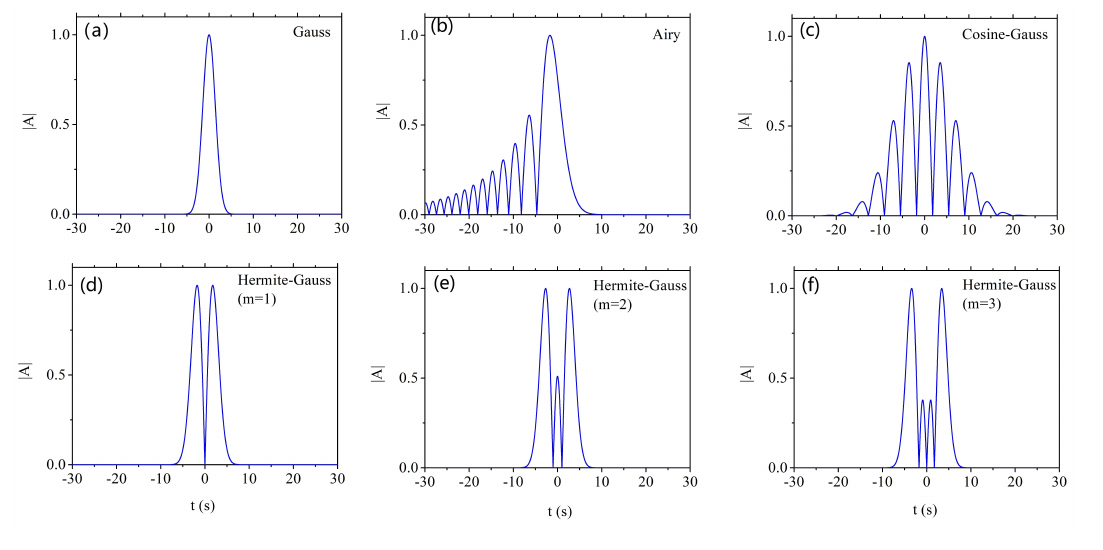
Figure 2. Envelopes (blue curves) of different wavepackets presented in this chapter for x = 0. ( a ) Gaussian packet A ( t ) = exp ( − ( t / t 0 ) 2 ) , with duration t 0 = 2.0 s; ( b ) Airy wave packet A ( t ) = Ai ( t / t 0 ) exp ( α t / t 0 ) , with truncation α = 0.15 and width of main lobe t 0 = 2.0 s. ( c ) Cosine-Gauss packet A ( t ) = cos [ ω 0 tsin ( θ )] exp ( − ( t / t 0 ) 2 ) , with ω 0 = 9 rad/s, θ = 5.5 ◦ , t 0 = 9 s. ( d – f ) Hermite-Gauss packet with different order A ( t ) = H m exp ( − ( t / t 0 ) 2 ) , where H m is Hermite polymial and t 0 = 2.5